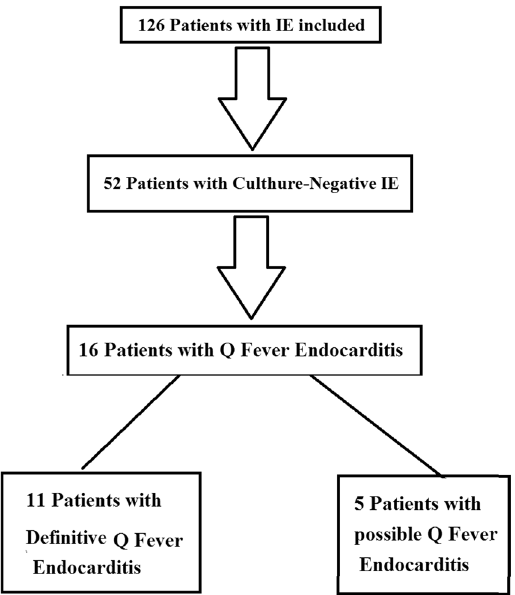
Figure 1. Distribution of patients diagnosed with Q fever infective endocarditis (IE) according to Raoult